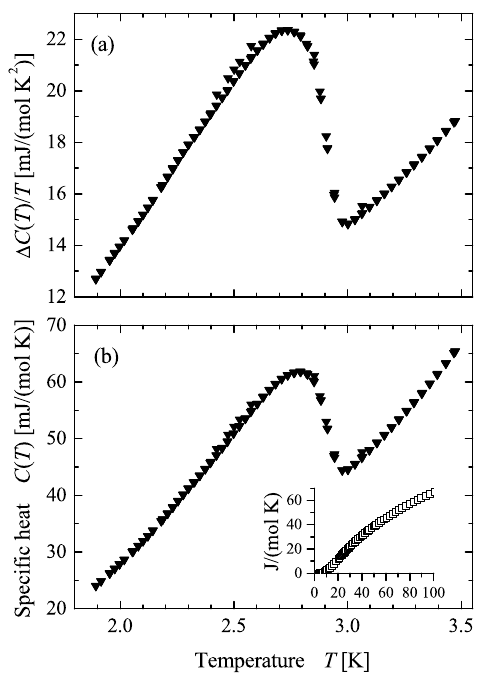
Figure 6. Specific heat of AuPdScAl: ( a ) specific heat divided by temperature ( C / T ); ( b ) temperature dependent specific heat C ( T ) on the temperature scale in the region of superconducting transition; the inset shows C ( T ) in a larger temperature